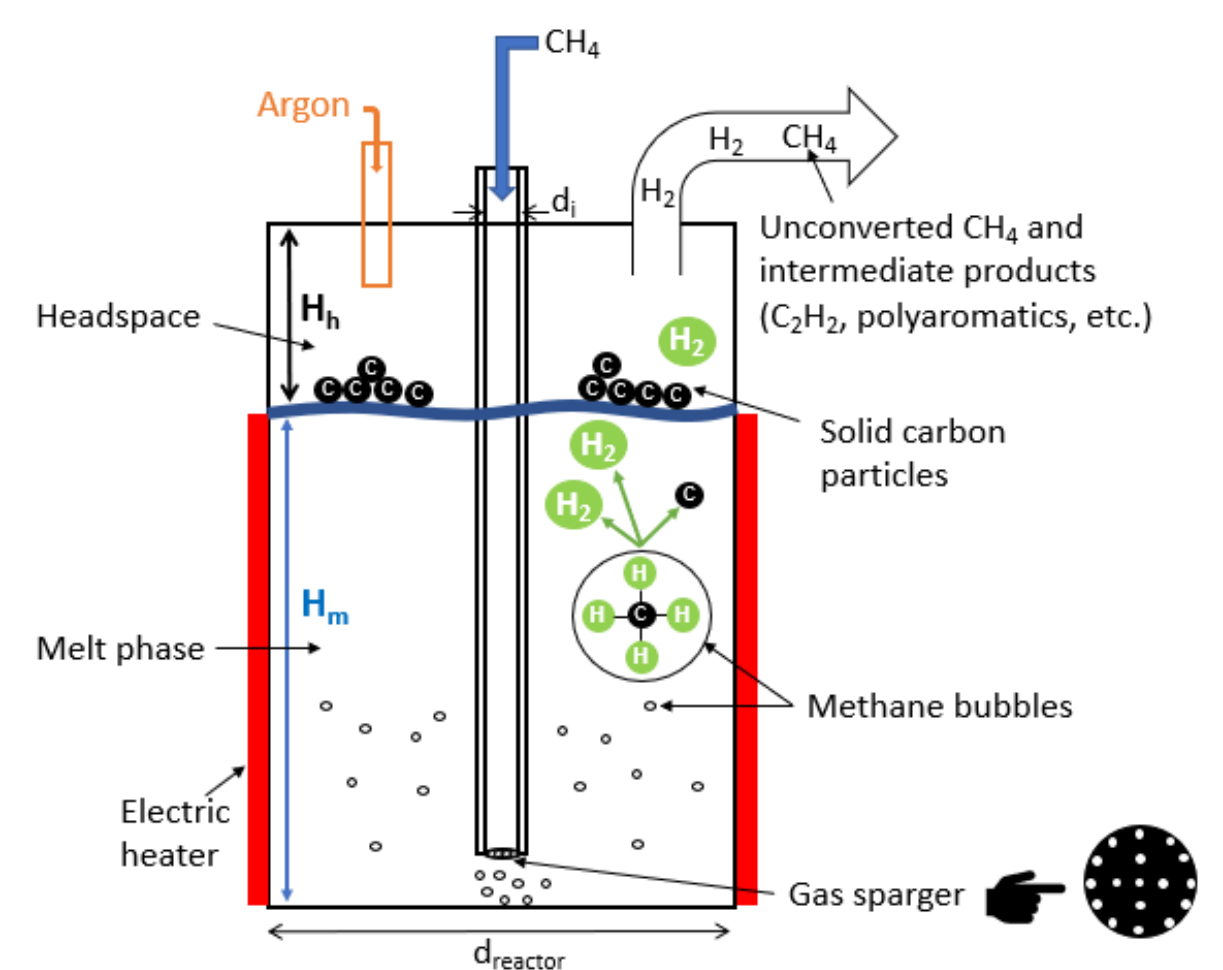
Figure 3. Representative scheme of a molten media reactor for methane pyrolysis .